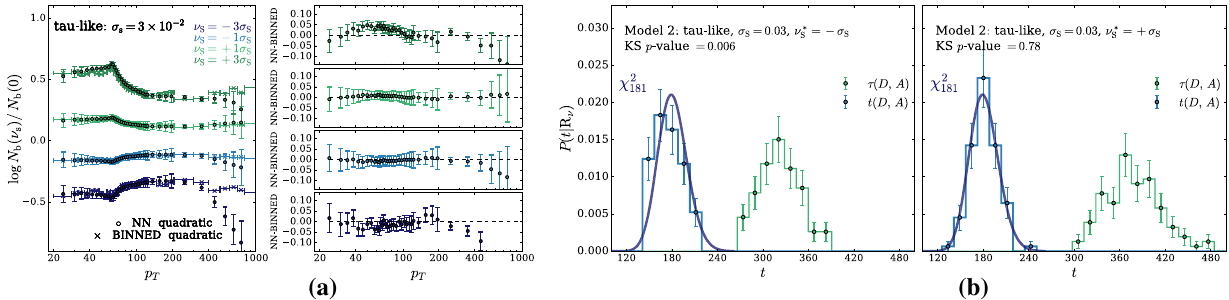
hypothesis at ν s = − 1 (left side) and ν s = + 1 (right side) for the τ -like regime. Both plots have been obtained enriching the reference sample in the region of high transverse momentum with 400 (cid:16) 000 additional